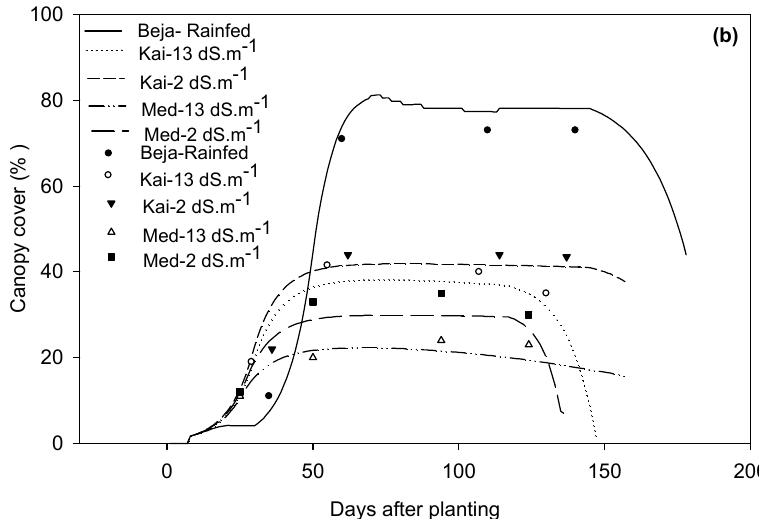
Figure 4. Simulated and observed canopy cover for ( a ) tolerant and ( b ) sensitive barley varieties.